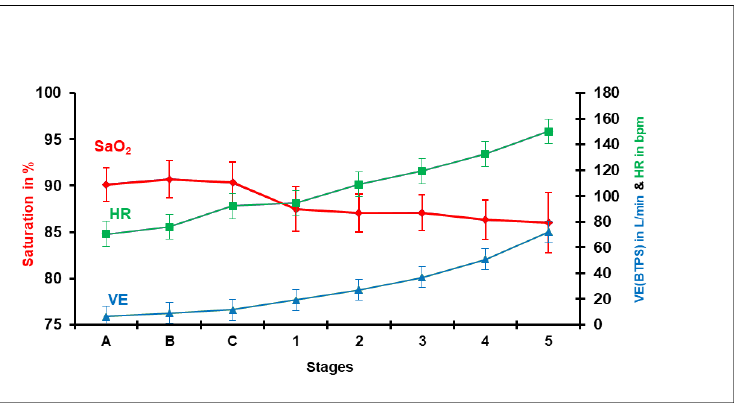
Figure 2. Mean values and standard deviation of oxygen saturation (SaO 2 ) obtained by pulse- oximetry, heart rate (HR), and ventilation (VE) in Body Temperature, Pressure water vapor Saturated (BTPS) during the three resting stages, (A) supine, (B) sitting, and (C) standing, and then during the five stages of exercise using the Modified Bruce exercise protocol mph/gradient (0/0, 2/0, 2/5, 2/10, 3/12, 4/14) in 15 healthy